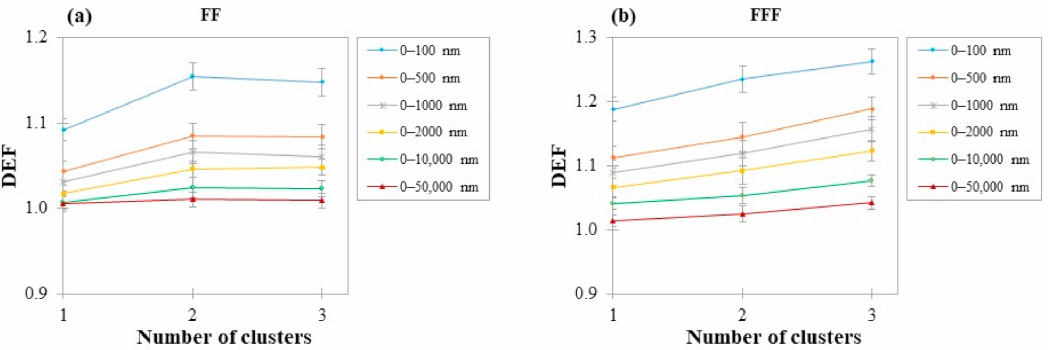
Figure 5. ( a ) Comparison of DEF among regions of interest for different numbers of AuSlabs in the case of 6 MV photon spectrum in presence of FF; ( b ) Comparison of DEF among regions of interest for different numbers of AuSlabs in the case of 6 MV photon spectrum in absence of FF. The size of all examined clusters was 100 nm and the photon field used to irradiate AuNPs clusters was 5 × 5 cm 2 . AuNPs clusters were positioned at a depth of 2 cm inside the mathematical water phantom. Points are connected with lines for illustration